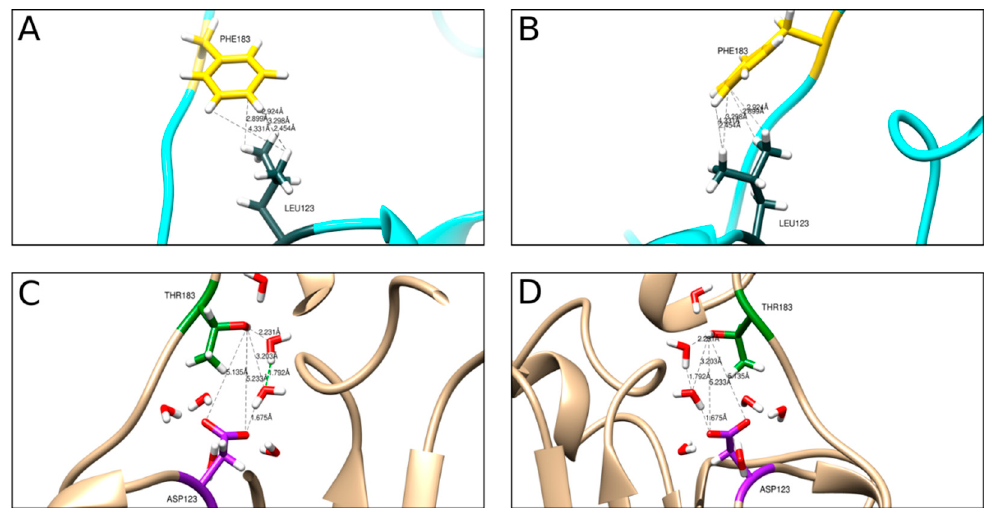
Figure 10. Computational model of a fragment of the BMV capsid protein. ( A , B ) depict wild-type virus hydrophobic interactions of two interacting amino acid residues on two neighboring chains. Leu123 in slate gray, Phe183 in yellow, rest of the protein in cyan. Black dashed lines show distances (in Å) between residues involved in hydrophobic contacts. ( C , D ) depict the hydrogen bond interaction pattern between mutated residues. Asp123 is shown in magenta, Thr183 in green, and the rest of the protein in beige. The electrostatic interactions between residues are mediated by water molecules. Black dashed lines show electrostatic interactions between residues and residue/water molecules.